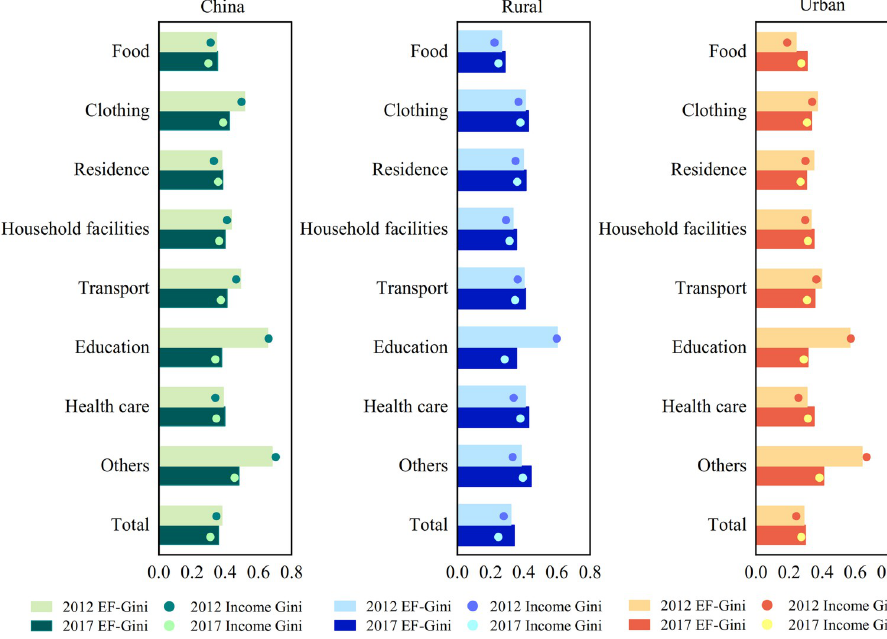
Fig 5. EF-Gini and income Gini coefficient for overall, rural, and urban China in 2012 and 2017. The EF-Gini and income Gini coefficient are divided into eight consumption expenditure categories.